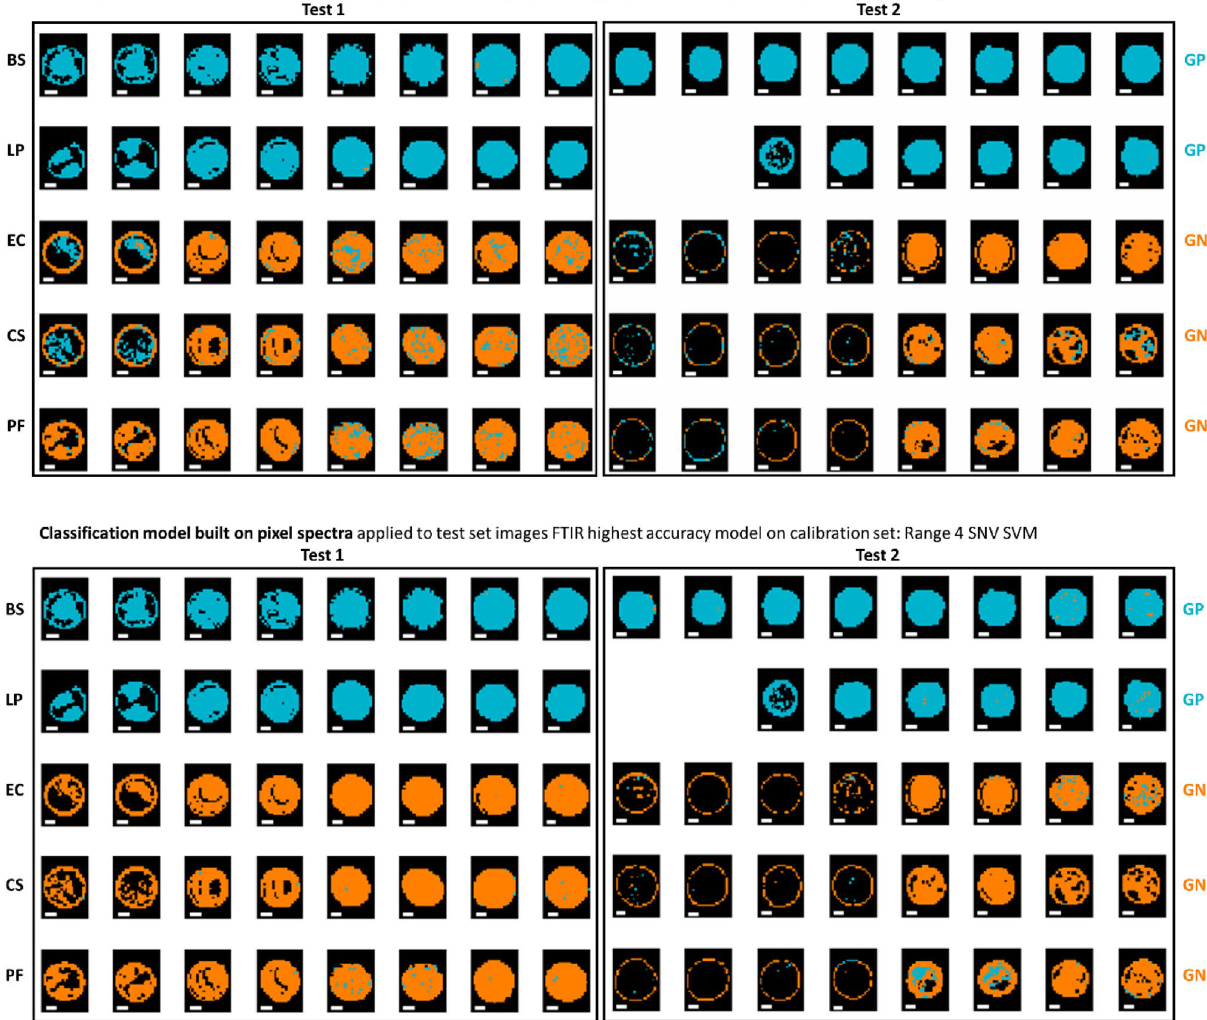
Figure 4. Classification maps for samples in the test sets obtained from the best mean (top panel) and pixel-level (bottom panel) FTIR models for GP/GN classification. Pixels classified as GP/GN are shown in blue or orange respectively. Each replicate has two drops. BS: Bacillus subtilis ; LP: Lactobacillus plantarum ; EC: Escherichia coli , CS: Cronobacter sakazakii ; PF: Pseudomonas fluorescens. White scalebar indicates 1 mm (width) × 0.2 mm